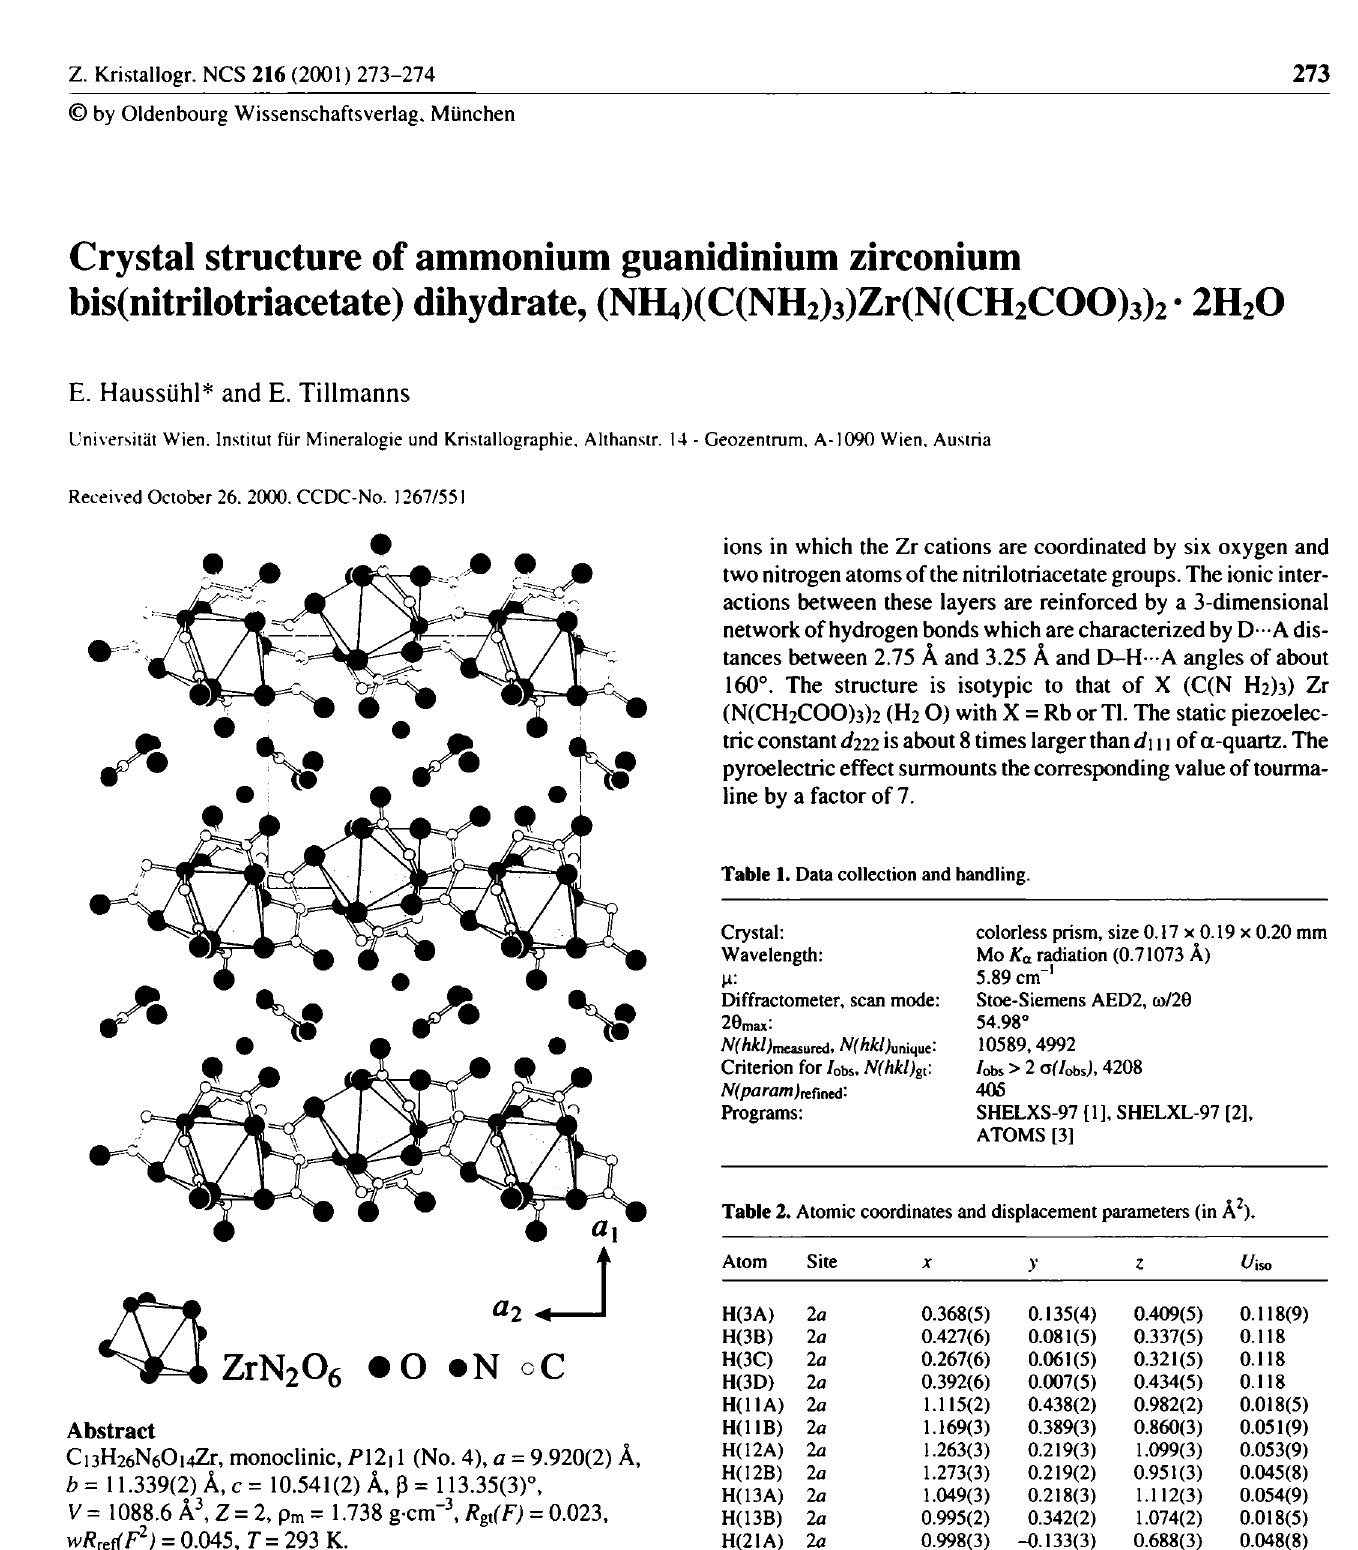
Table 2. Atomic coordinates and displacement parameters (in Ä 2